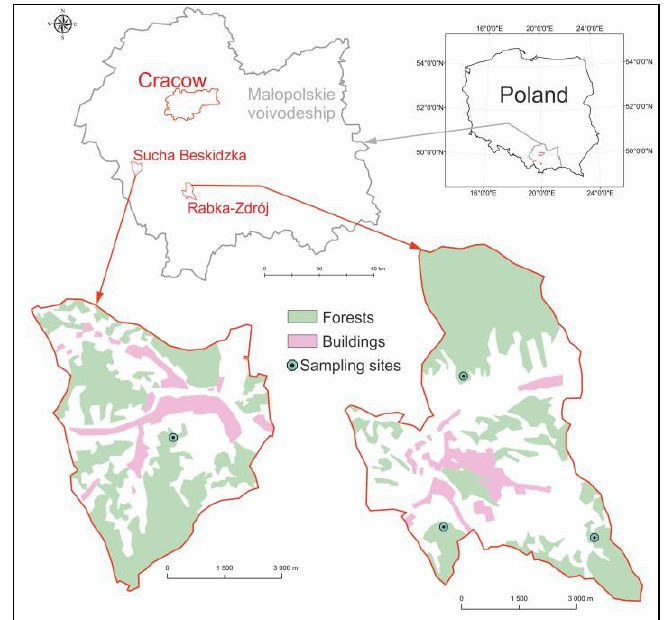
Fig. 1. Location of the study